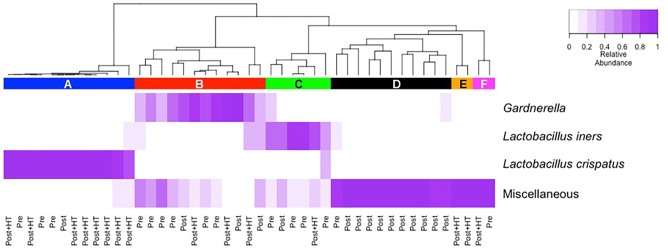
Cluster analysis of vaginal bacterial communities found in 45 women who were either premenopausal, postmenopausal, or postmenopausal and receiving hormone replacement therapy. The dendrogram was created as described in the Materials and Methods section. The number of clusters within the data was determined by maximizing the silhouette width as described by Rousseeuw (1987).